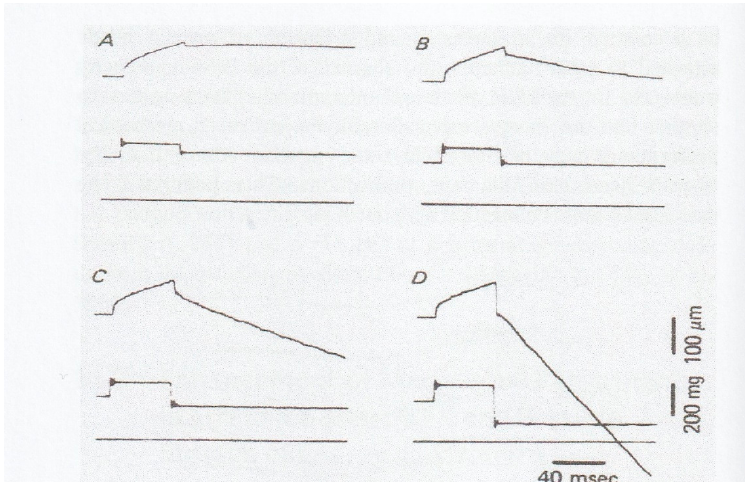
Figure 10. Enhancement of mechanical performance in tetanized intact muscle fibers when they are first lengthened by quick changes in load from Po to P > Po and then subjected to quick changes in load from P > Po to P < Po . Note that the fiber shortens under a load = Po ( B ), as well as under loads P < Po ( C , D ), while it is lengthened under a load > Po (A); and also note that the fiber starts shortening without any velocity transients. From Ref. [15].